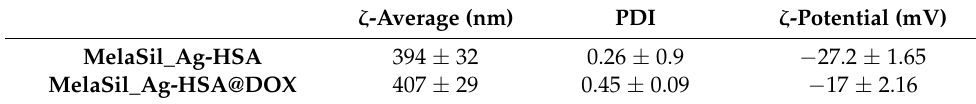
Table 1. DLS and ζ -potential of MelaSil_Ag-HSA NPs before and after DOX